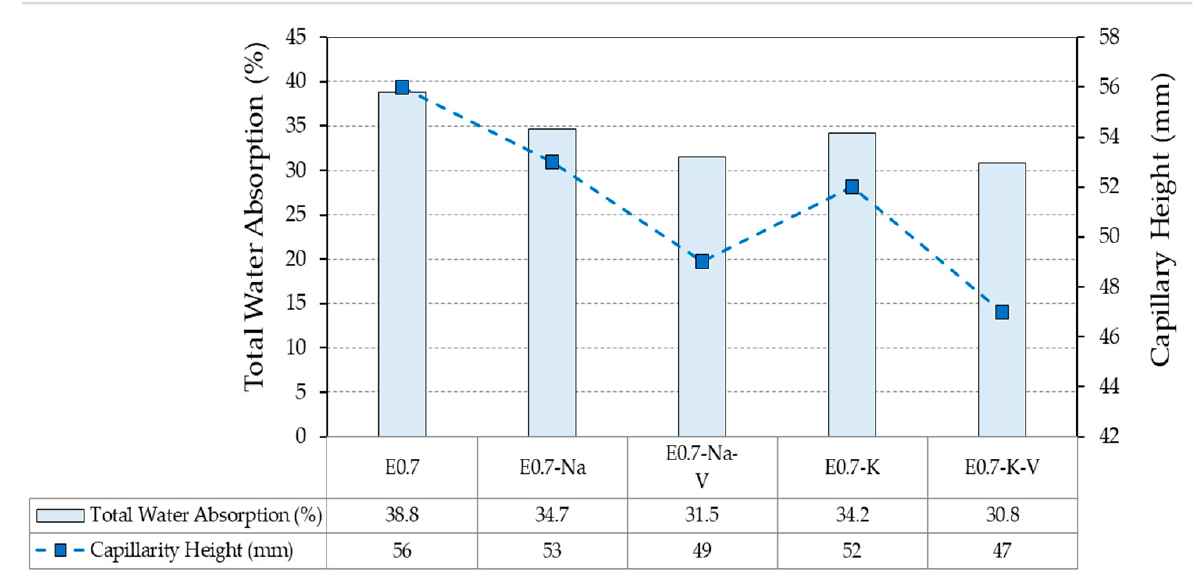
Figure 3. Capillarity height and total water absorption test results compared.